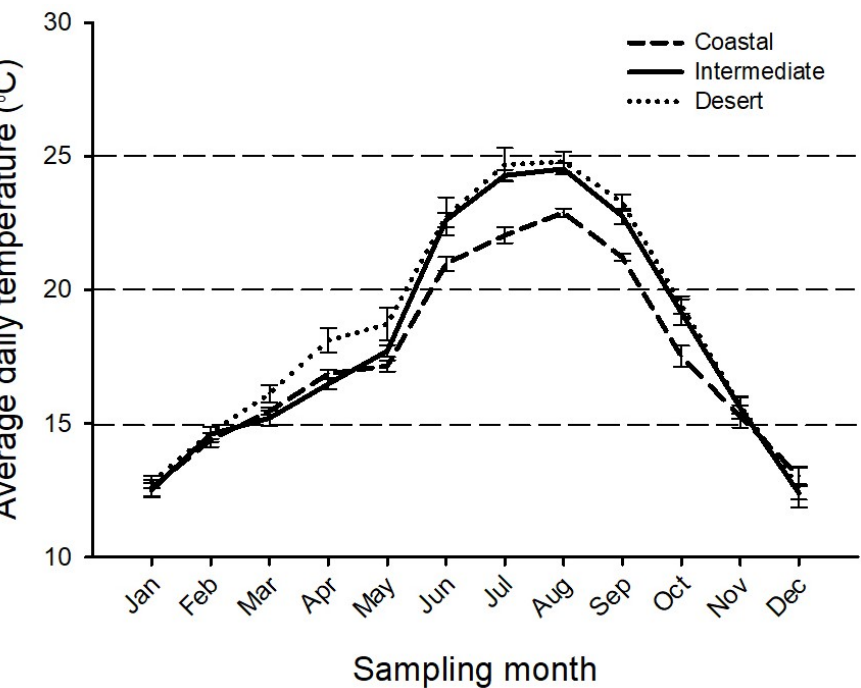
Figure 1. Mean (±SE) temperatures of sampling periods at study sites belonging to either the coastal (CIMIS stations: 62, 75, 174), intermediate (CIMIS stations: 44, 78, 153) or desert (CIMIS stations: 207, 239, 251) climate zones in southern California from January 2016 through December 2017 study period. Sampling months were grouped into three seasons: cool (10–15 °C), moderate (15.01–20 °C), or warm (>20.01 °C).